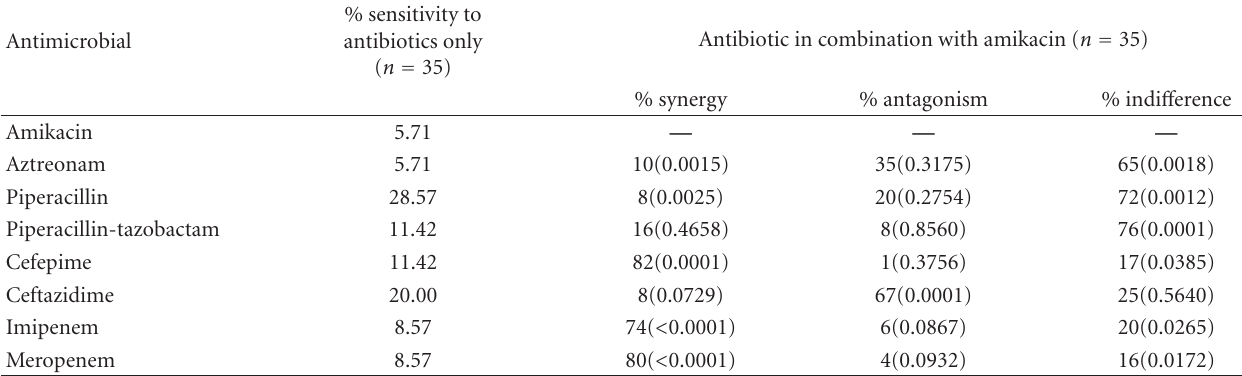
Table 3: Susceptibility and synergy interaction profile of multidrug-resistant P.